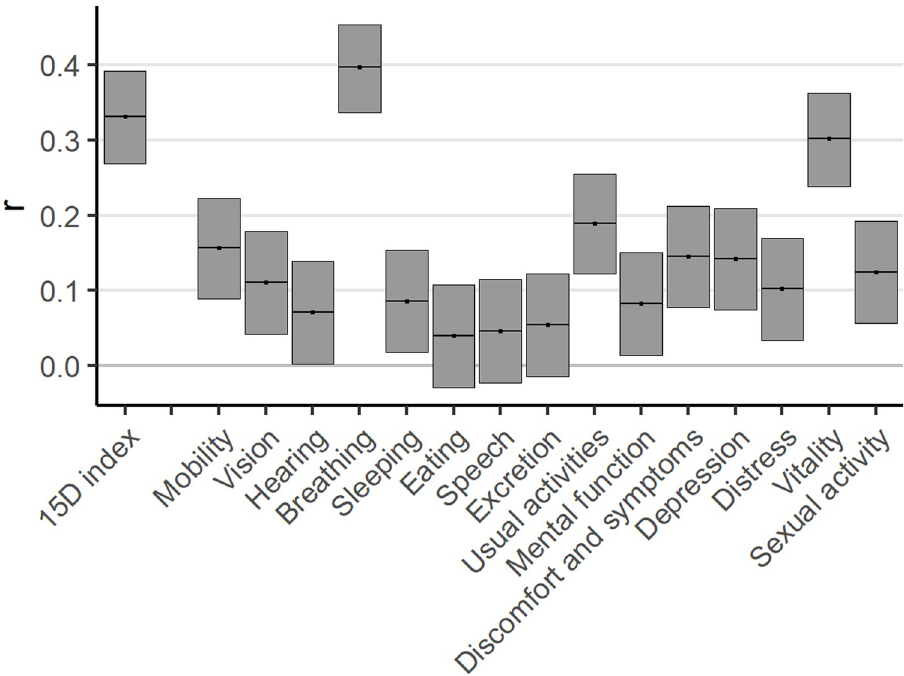
Fig 1. Spearman correlation coefficients (95% confidence intervals) between one-year changes in the CCS and the 15D and its dimensions.